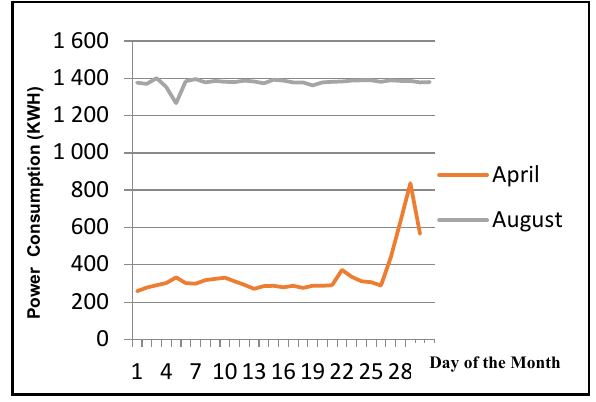
Figure 8 . Energy consumption in April and